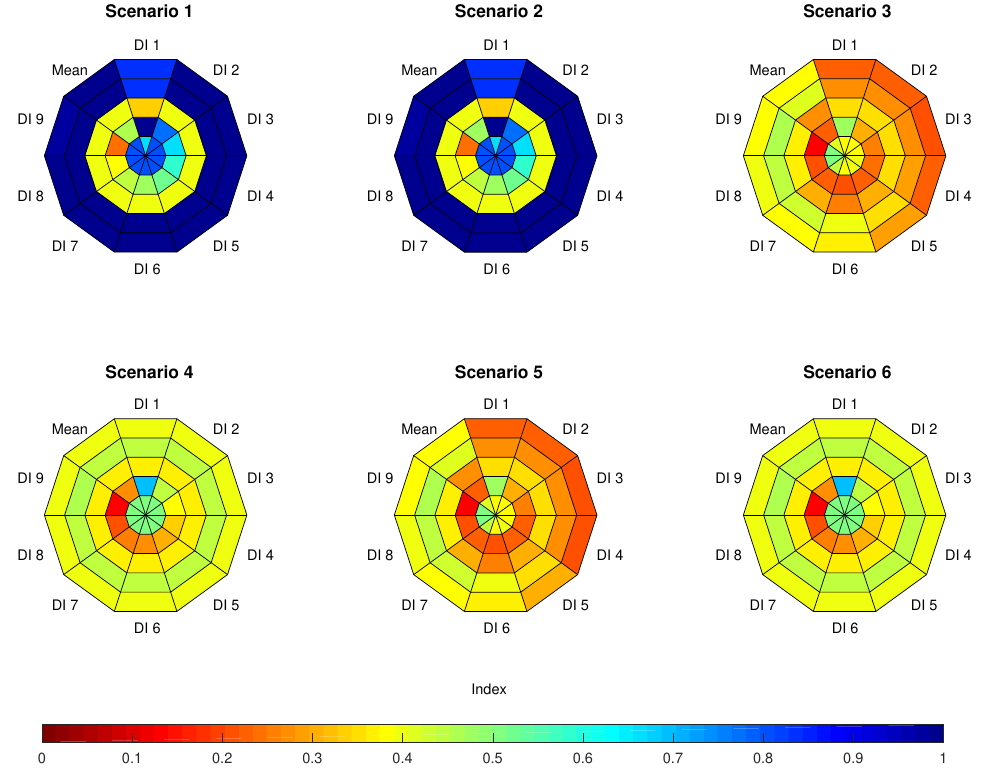
Figure 6. Profits and seasonal use of resources obtained from the optimisation process for each scenario at situation a. Each ring represents a resource index organised as follows (from inside to outside): Land, water, labour and capital used, and profit; each slice corresponds to a decile of water availability